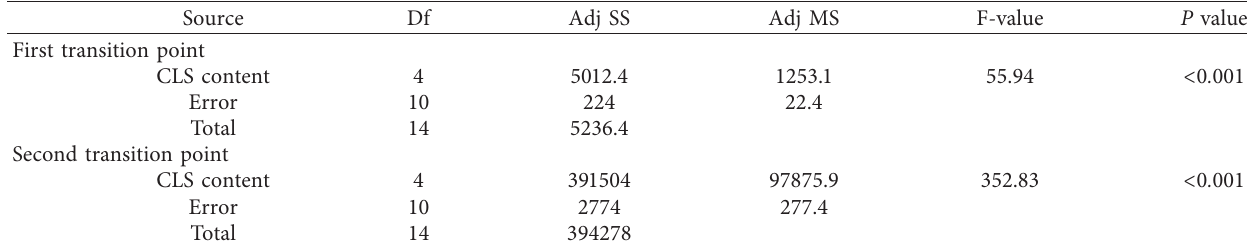
Table 12: One-way ANOVA: transition point values versus CLS content.